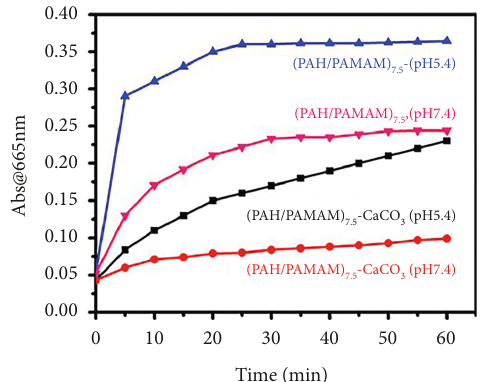
Figure 10: The release profile of MB from the medium crossed- linked (PAH/PAMAM) 7.5 film and (PAH/PAMAM) 7.5 -CaCO 3 film at various pH